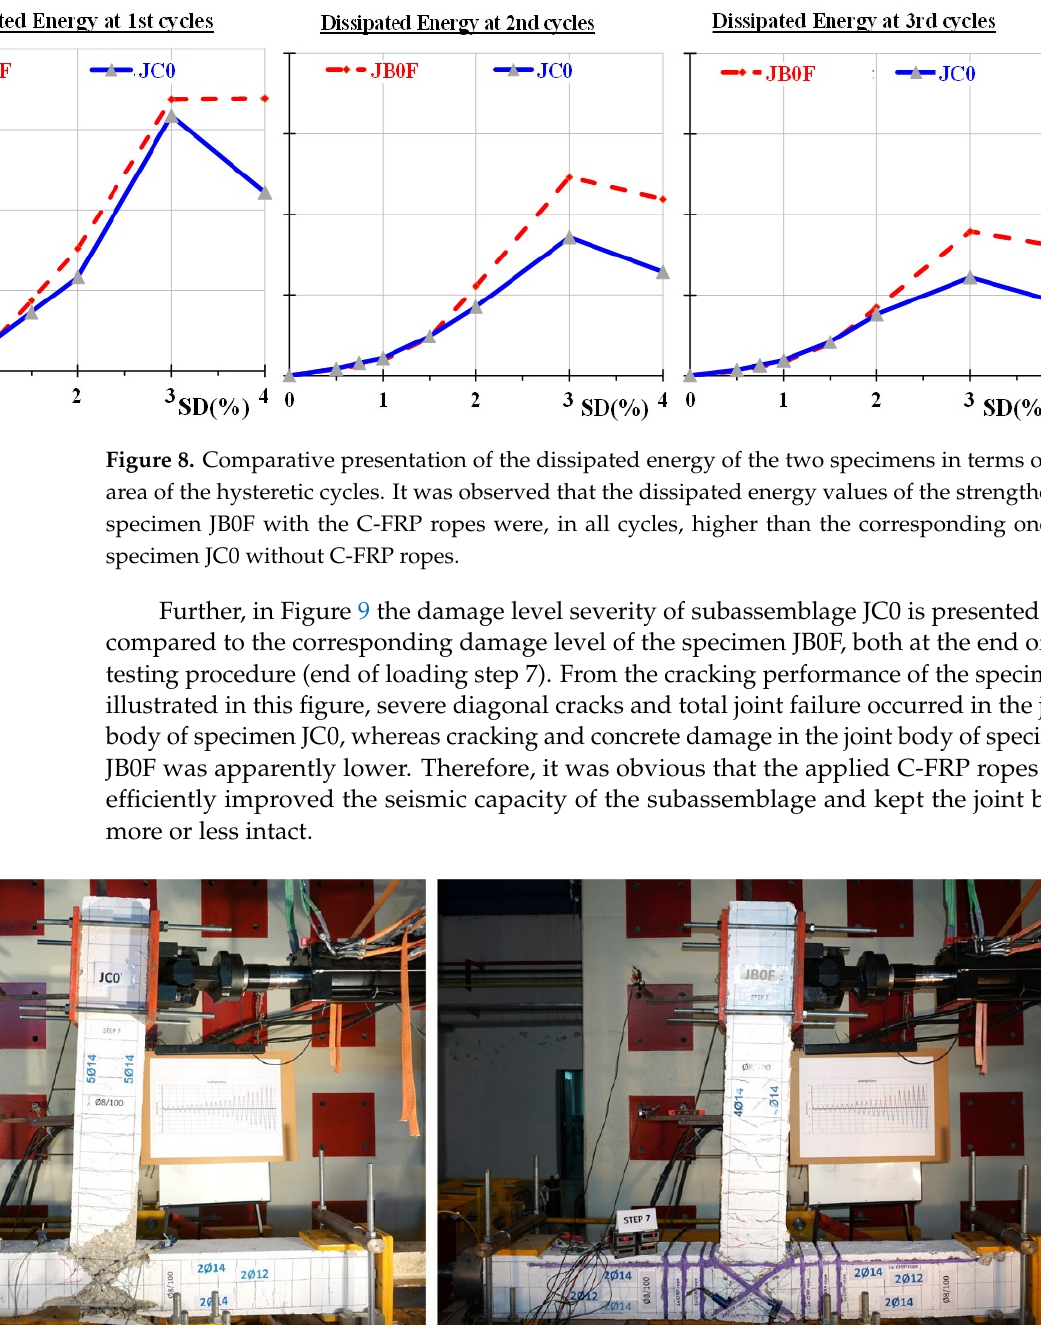
Figure 7. Hysteretic performance of subassemblages JC0 and JB0F.